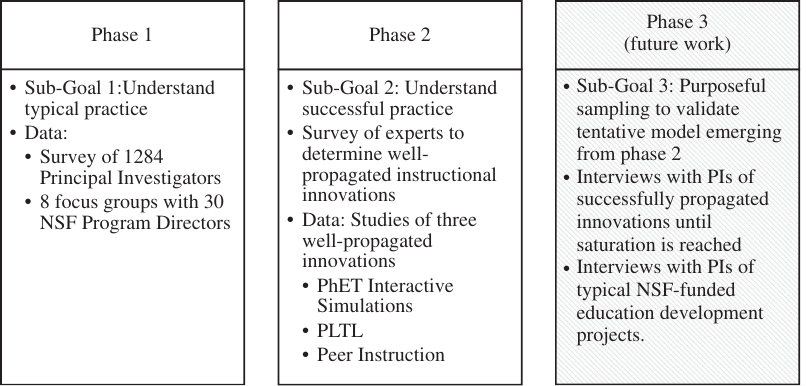
FIG. 1. Overview of the larger study, carried out over five years. This paper describes phases 1 and 2, which have resulted in a tentative model of educational development for successful